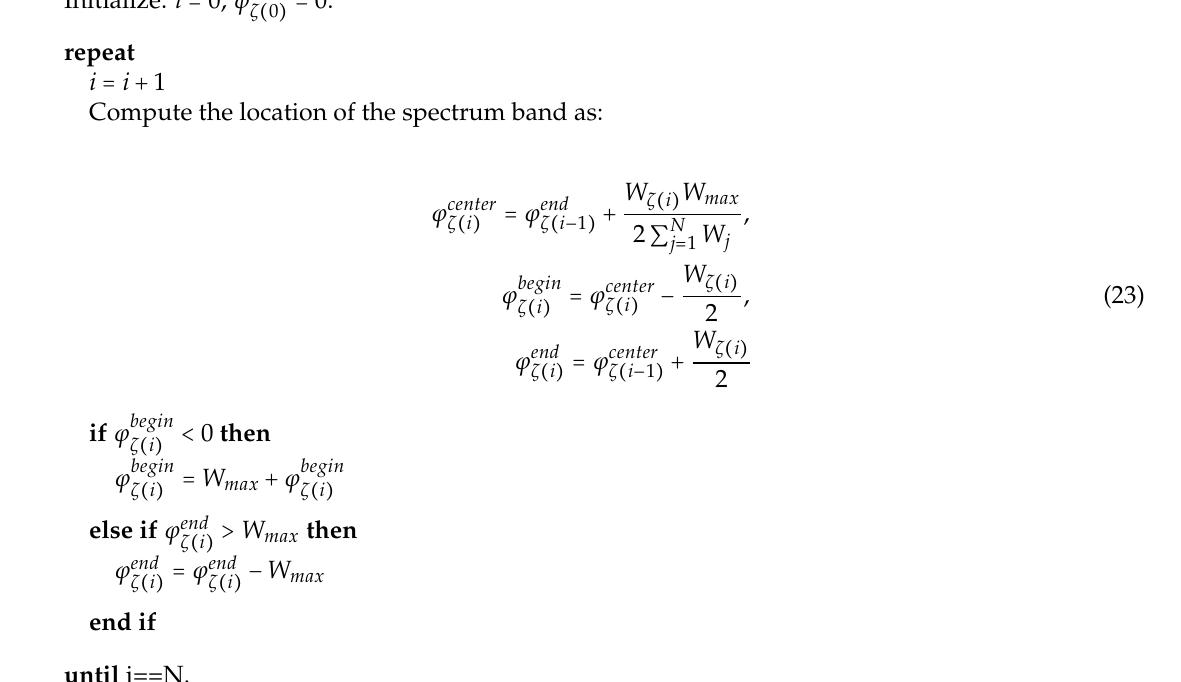
Algorithm 3 Resource scheduling of frequency